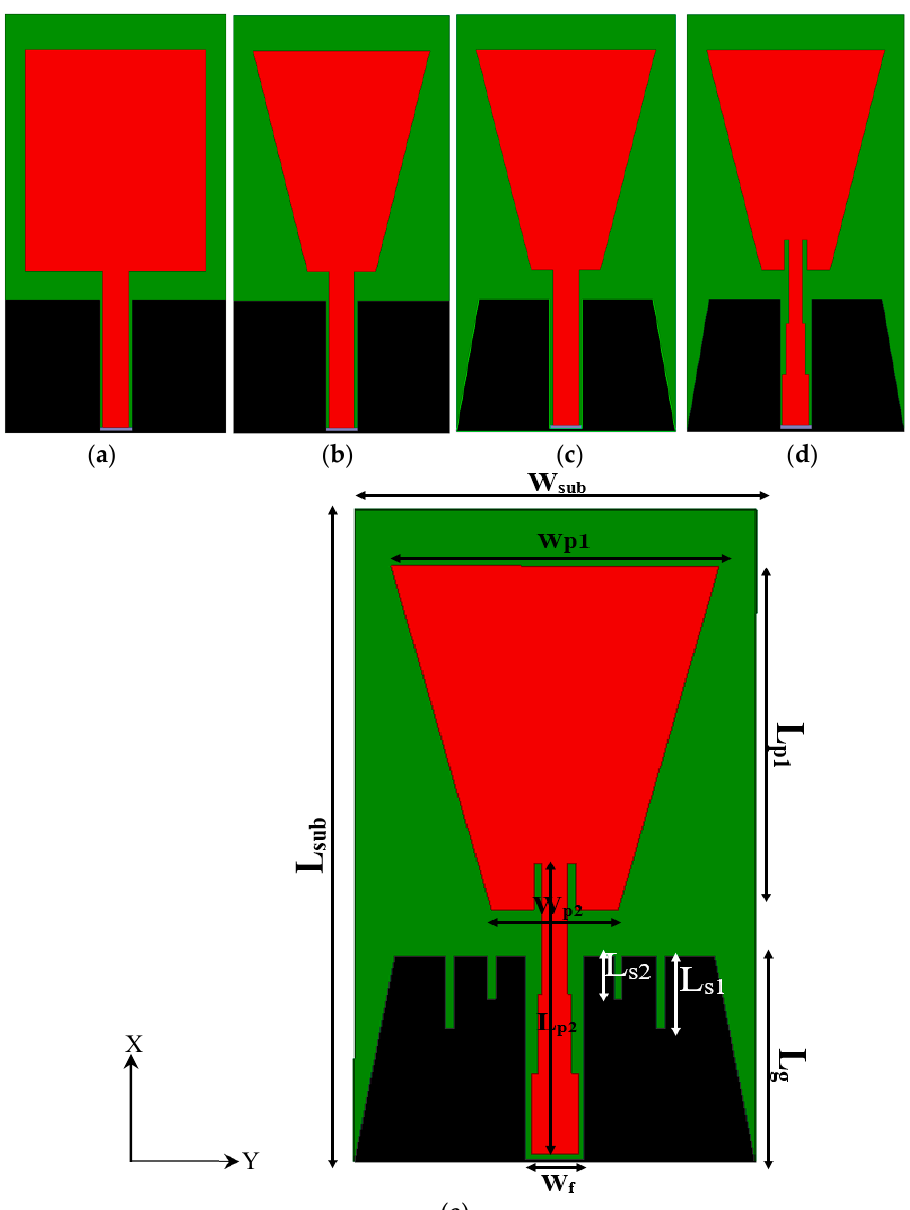
Figure 2. ( a – d ) The design steps of CPW-based monopole antenna and ( e ) final design of CPW-based monopole antenna.